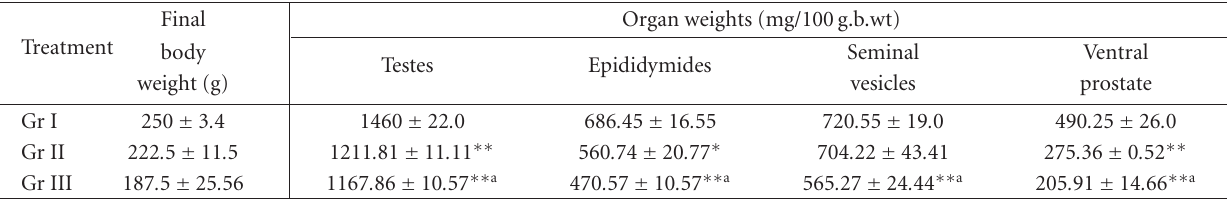
Level of significance, ∗ P < . 01, ∗∗ P < . 001 compared with Gr I (controls). Level of significance, a P < . 01 compared with Gr II (compound 1 treated